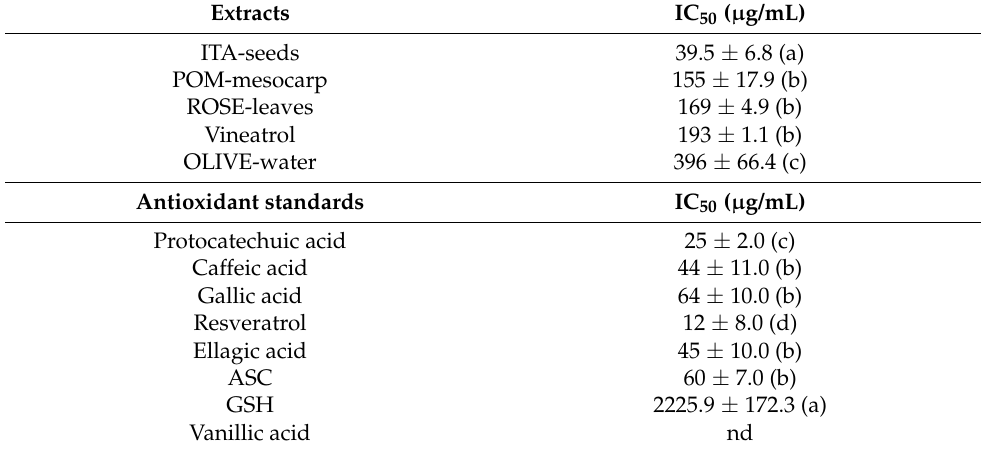
Table 2. Protective effect of extracts and single antioxidants toward UV-induced oxidative stress in RBC membranes. The protective capacity of the different samples is expressed as IC 50 (IC = inhibiting concentration), i.e., as sample concentration ( µ g/mL) that determines 50% of inhibition of MDA release induced by radiation stress. Values are means ± SD of three replicates. Different letters (a), (b), (c), (d) indicate a statistical difference ( p < 0.05) according to